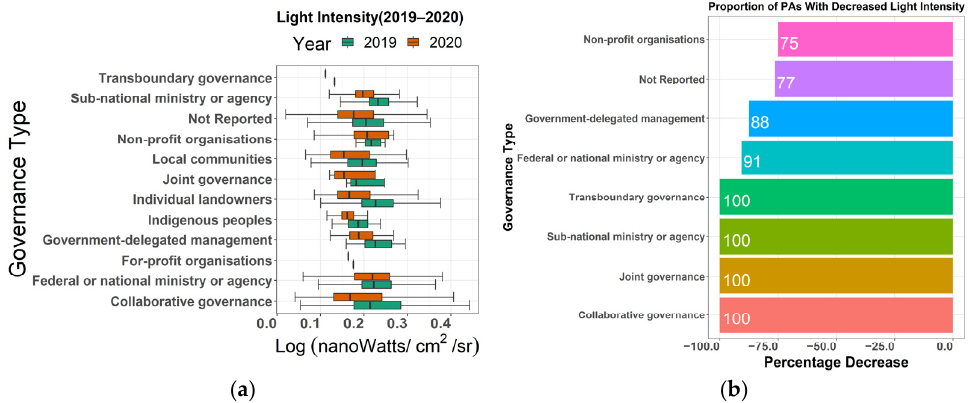
Figure 7. ( a ) Comparing light intensity across governance types; ( b ) proportions of PAs with de- creased light intensity across governance types.